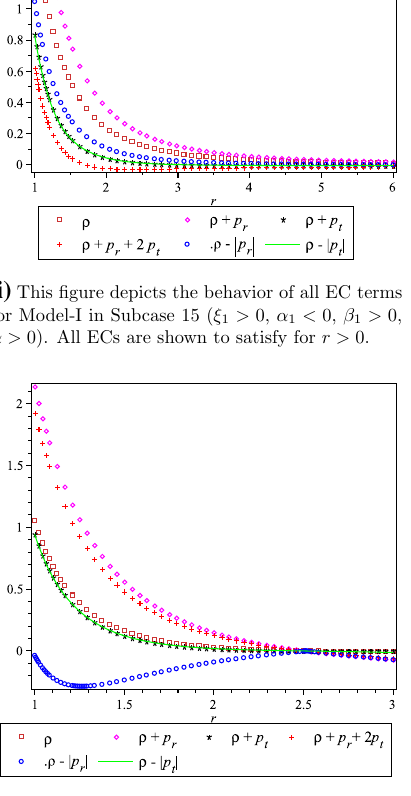
(k) This figure depicts the behavior of all EC terms (l) This figure depicts the behavior of all EC terms